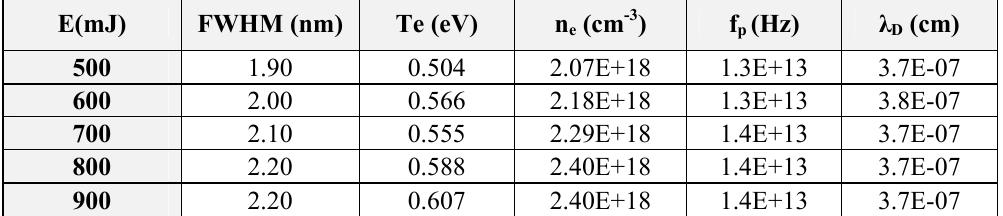
at X=0.4 with different laser energies. 2